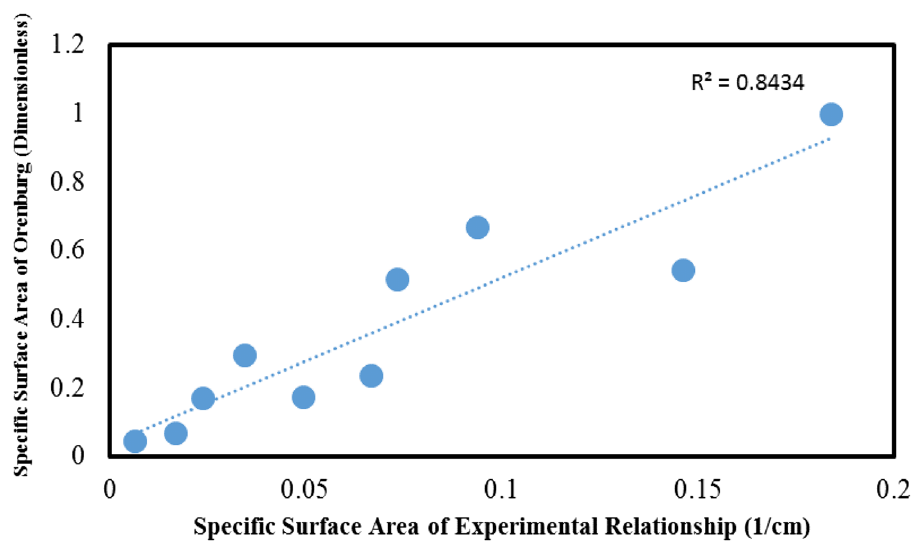
Fig. 12 Specific surface area of Orenburg data versus experi- mental relationship in this